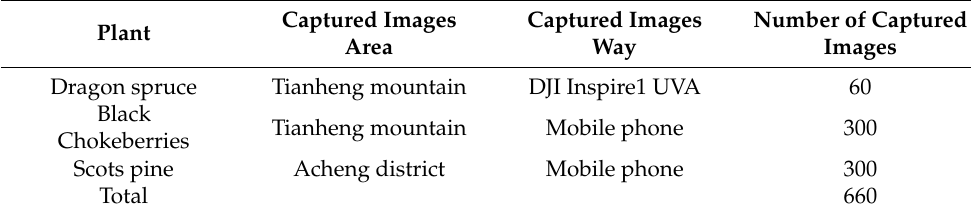
Table 1. Information about the collected dataset. Captured Images Captured Images Number of Captured Plant Area Way Images Dragon spruce Chokeberries